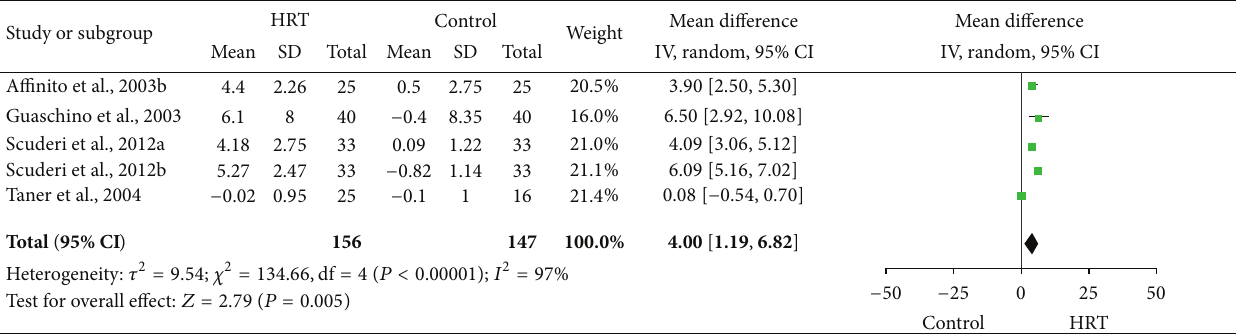
Figure 3: Forest plot of Schirmer score change without anesthetics for the effect of HRT on DES patients. Study of Affinito et al. (2003b) indicates that the data were obtained without anesthetics. Study of Scuderi et al. (2012a) indicates that the data were extracted with the HRT group and control group, and study of Scuderi et al. (2012b) indicates that the data were extracted from reversed groups; that is, the HRT group and control group were reversed after a washout period. HRT: hormone replacement therapy; SD: standard deviation; CI: confidence interval; and IV: inverse